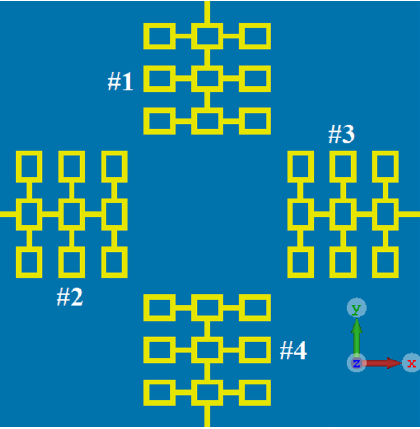
Figure 1. Top view showing the layout of the proposed antenna array consisting of four radiating elements with a standard ground